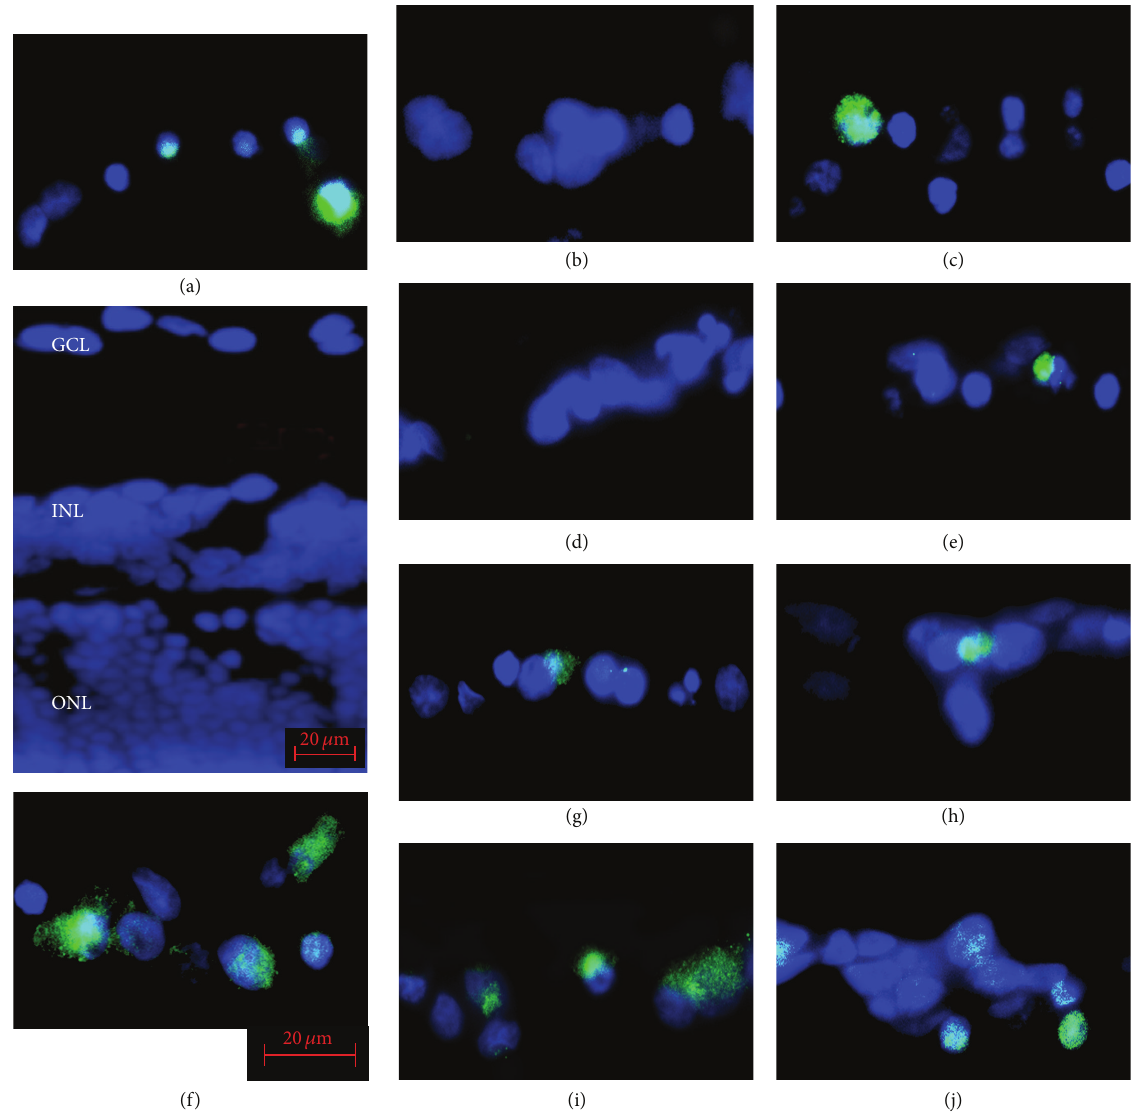
Figure 2: Representative photomicrographs of NF- 𝜅 B immunopositive cells in the ganglion cell layer (GCL) of isolated rat retinas. In retinas cultured in glucose-AGE-BSA (f), the number of immunopositive cells in the GCL is significantly higher than in serum-free control media (a). In AGEs exposed retinas supplemented with NT-4 (glucose-AGE-BSA + NT-4) (g), with HGF (glucose-AGE-BSA + HGF) (h), with GDNF (glucose-AGE-BSA + GDNF) (i), and with TUDCA (glucose-AGE-BSA + TUDCA) (j) the number of NF- 𝜅 B immunopositive cells is fewer than that in AGEs exposed retinas without neurotrophic factors. The blue staining shows the DAPI-stained nuclei. Panels (b), (c), (d), and (e) are pictures of the serum-free media supplemented with NT-4 (b), HGF (c), GDNF (d), and TUDCA (e). INL, inner nuclear layer; ONL, outer nuclear layer. Bar = 20 𝜇